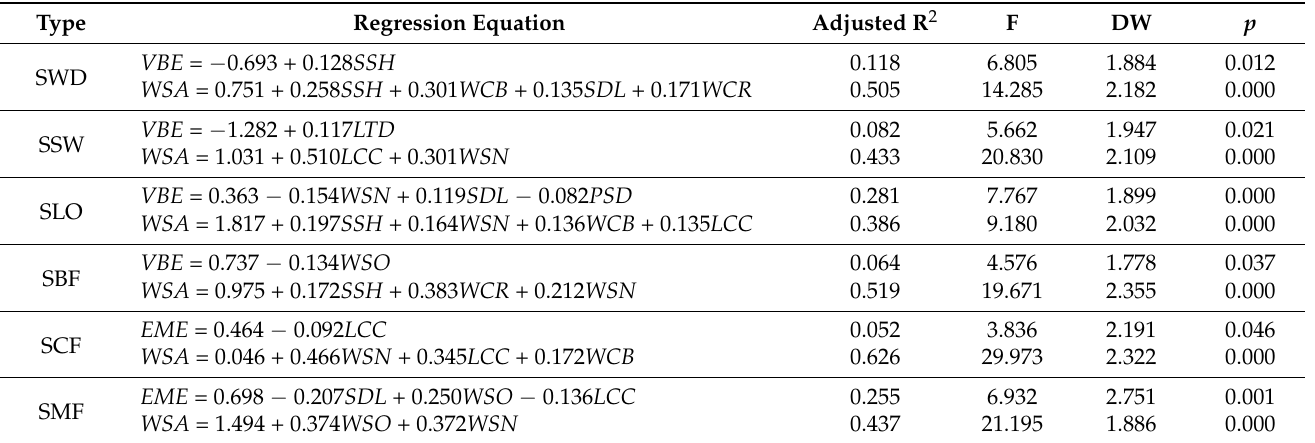
Table 5. Spatial perception factors affecting visual behavior and satisfaction preferences in different types of forest recreation landscape spaces. SWD: the space of dynamic water; SSW: static water space; SLO: the space of lookout; SBF: the space of broadleaf forest landscape; SCF: coniferous forest landscape space; SMF: mixed forest landscape space; VBE: the evaluation of visual behavior; WSA: Whether you are satisfied with